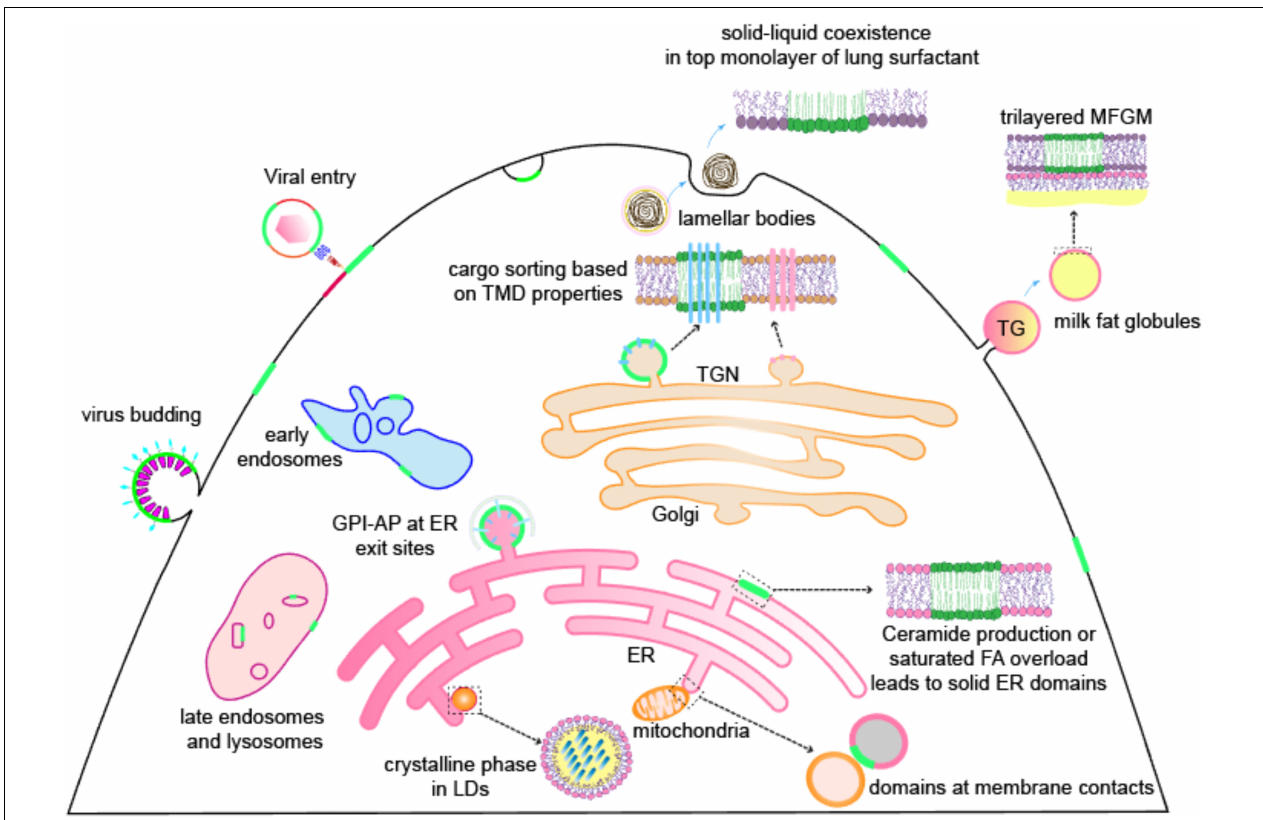
FIGURE 1 | Lipid domains are present on membrane systems, including not only the PM of mammalian cells but also many organellular membranes [endoplasmic reticulum (ER), Golgi, endosomes, lysosomes, lipid droplets (LDs)], viral membranes, and cell-secreted membrane structures like lung surfactants and milk fat globule membranes (MFGMs). Green color represents ordered domains (either liquid or solid). Other abbreviations: TGN, trans-Golgi network; TG, triglyceride; TMD, transmembrane domain; GPI-AP, GPI-anchored protein; FA, fatty